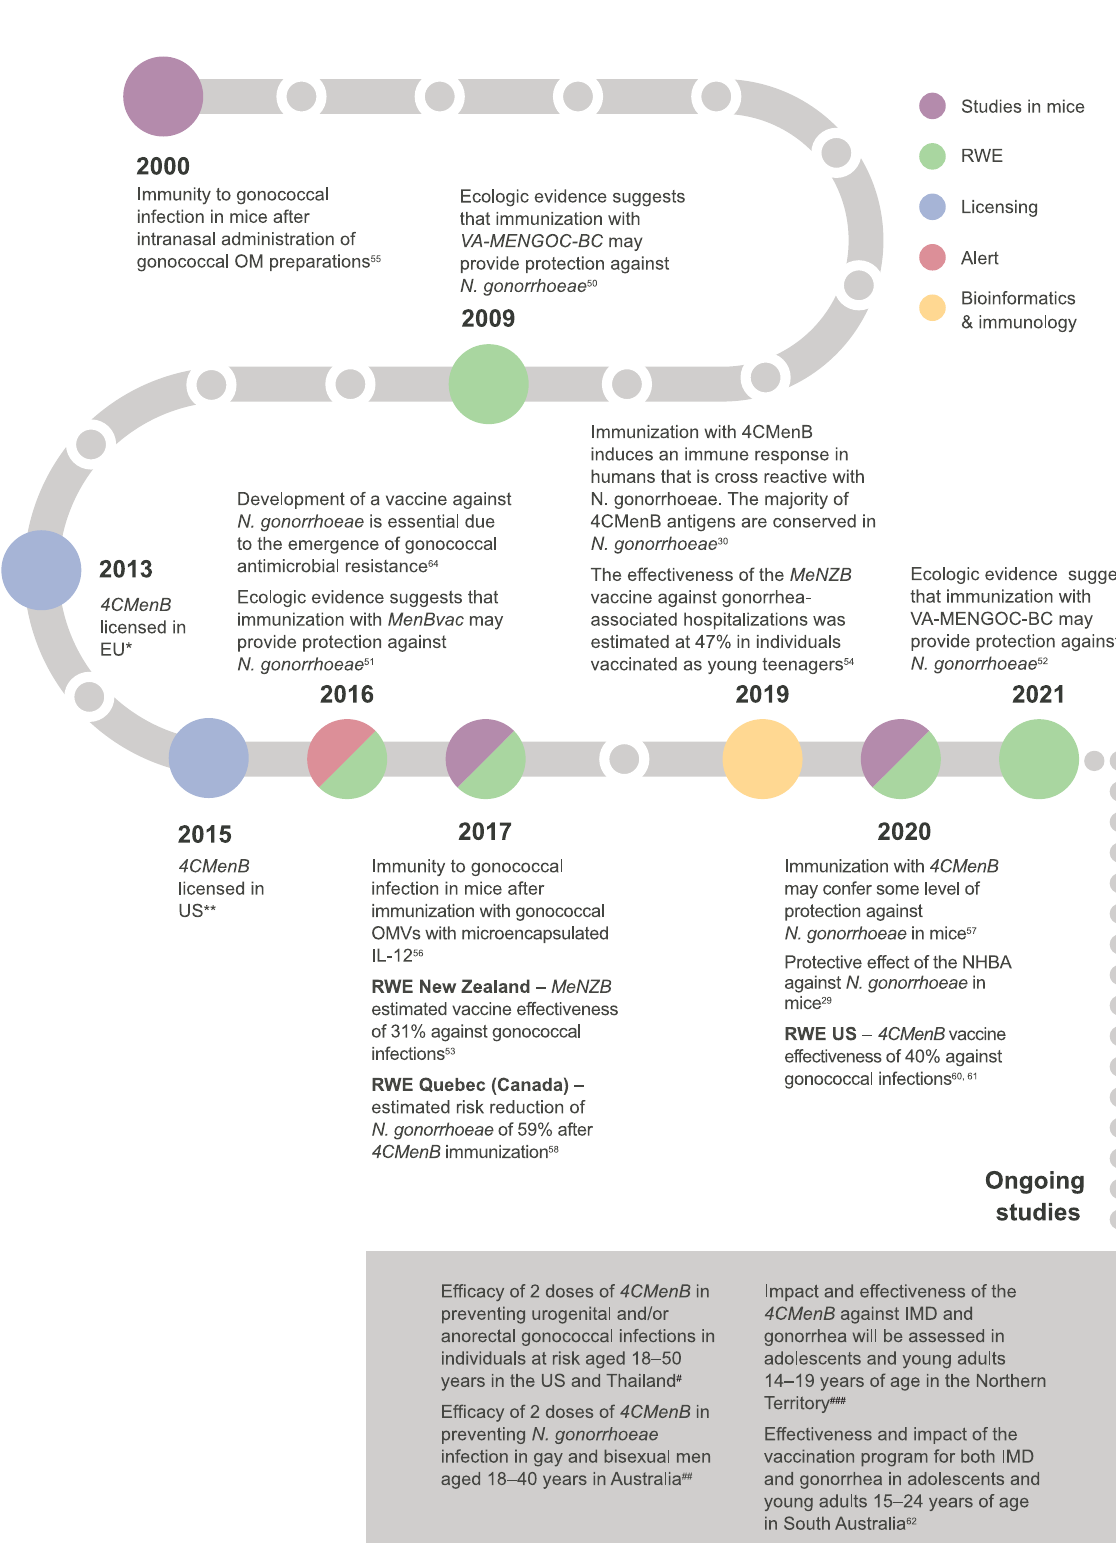
Fig. 3 Timeline of fi ndings and ongoing studies associated with Neisseria gonorrhoeae 29,30,50 – 58,60 – 62,64 . OM outer membrane, RWE real- world evidence, EU European Union, US the United States, OMV outer membrane vesicle, IL-12 interleukin 12, NHBA neisserial heparin binding antigen, IMD invasive meningococcal disease. *https://www.ema.europa.eu/en/documents/product-information/bexsero-epar-product- information_en.pdf. **https://www.fda.gov/media/90996/download. # ClinicalTrials.gov: NCT04350138. ## ClinicalTrials.gov: NCT04415424. ### ClinicalTrials.gov: